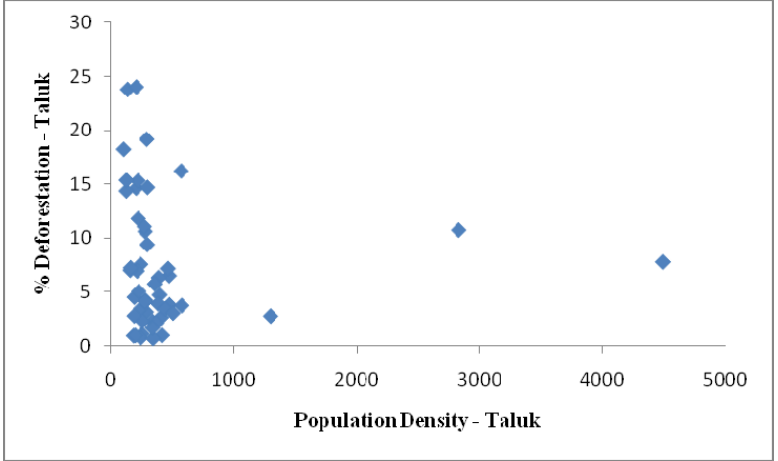
Figure 6b. Relationship between population density and the distribution of deforestation for